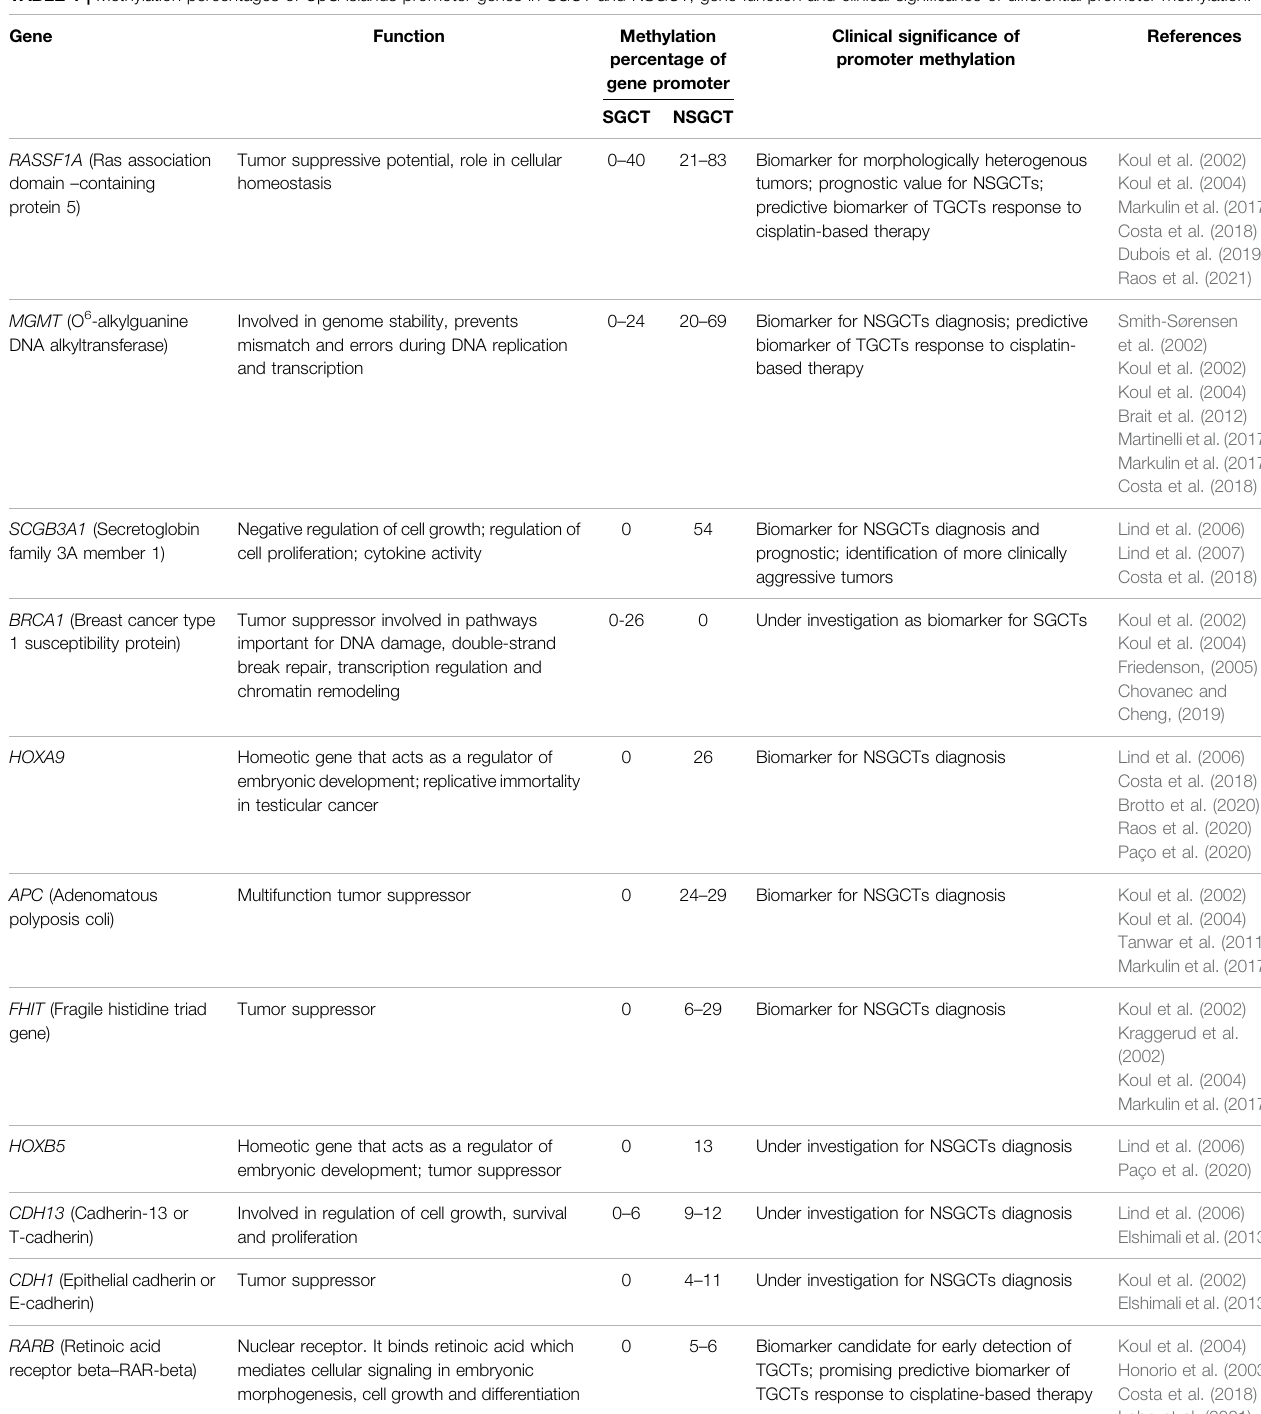
TABLE 1 | Methylation percentages of CpG islands promoter genes in SGCT and NSGCT, gene function and clinical signi fi cance of differential promoter